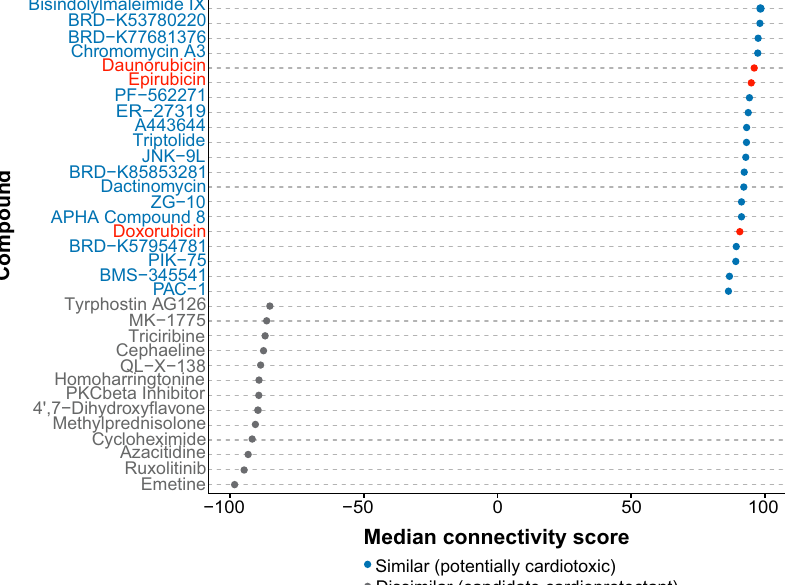
Fig. 4 Compounds with highly similar and dissimilar gene expression signatures to the TWAS. Expression signatures of compounds in CMap were compared with those of the TWAS. Compounds with a median connectivity score > 90 (similar gene signatures) or < − 90 (dissimilar gene signatures) are shown. Anthracyclines are highlighted in